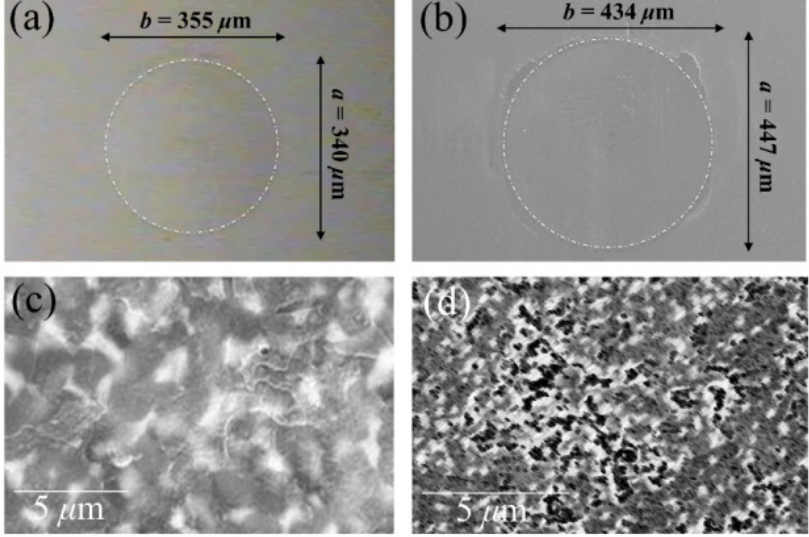
Figure 14. Optical images at the locations of elliptical scars on the pins made of Composites A and B after self-mating tests lasting 2 × 10 3 m in a pin-on-ball configuration (in ( a ) and ( b ), respectively); In ( c ) and ( d ), high magnification electron micrographs are shown from the damage scar regions (from ball side) in Composites A and B,